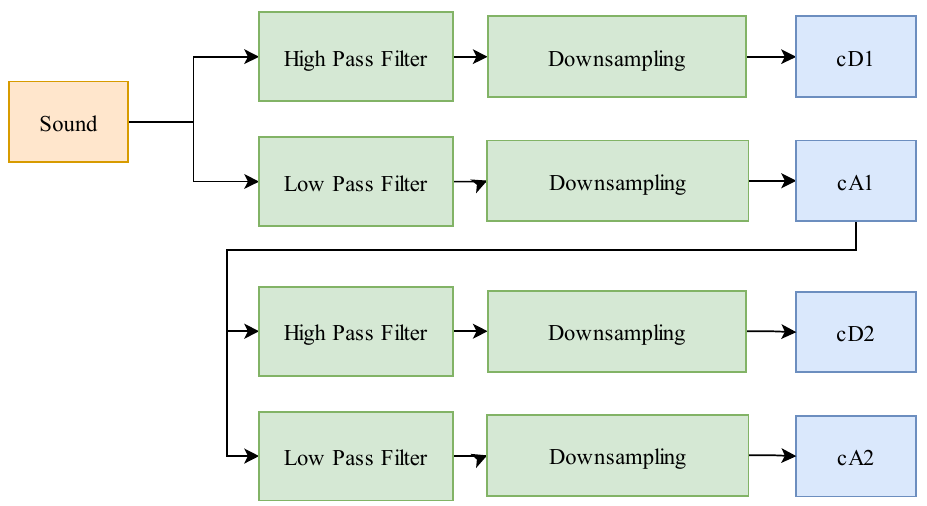
Figure 4. Two-level wavelet decomposition.